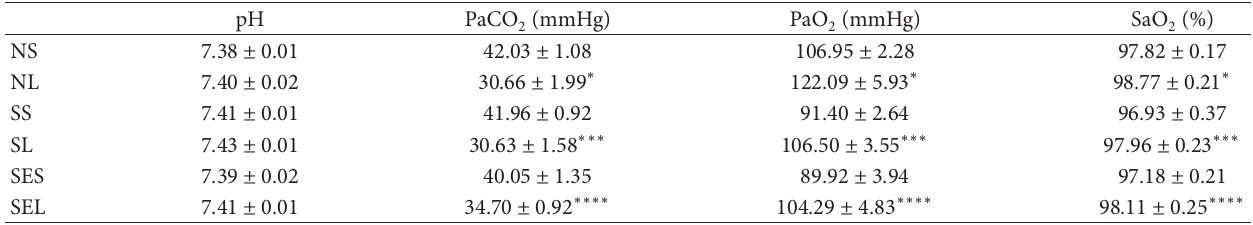
PaCO 2 : arterial carbon dioxide tension; PaO 2 : arterial oxygen pressure tension; SaO 2 : oxygen saturation. Data are expressed as means ± SEM of eight rats per group obtained 240min after injection of LPS or saline. ∗ P < 0.05, compared with the NS group; ∗∗∗ P < 0.05, compared with the SS group; ∗∗∗∗ P < 0.05, compared with the SES group (one-way